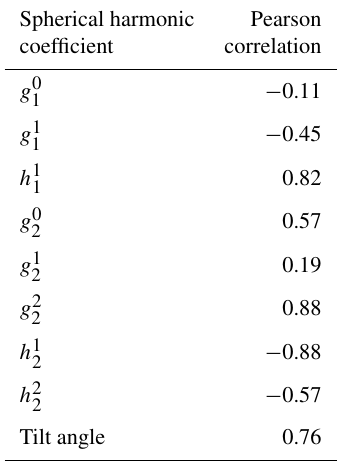
Table 1. Pearson correlation coefficients between AE and dipole and quadrupole spherical harmonic coefficients of the solar mag- netic field for